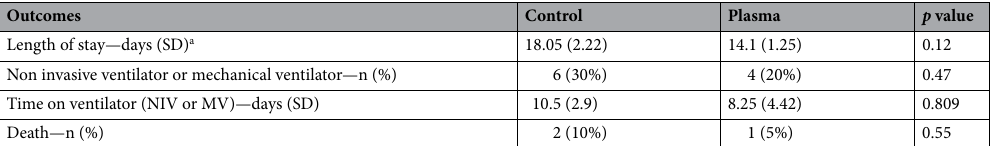
Table 3. Outcome of the study between the control and convalescent plasma study arms. a Length of stay included survivors only and was calculated from day of enrolment to discharge.